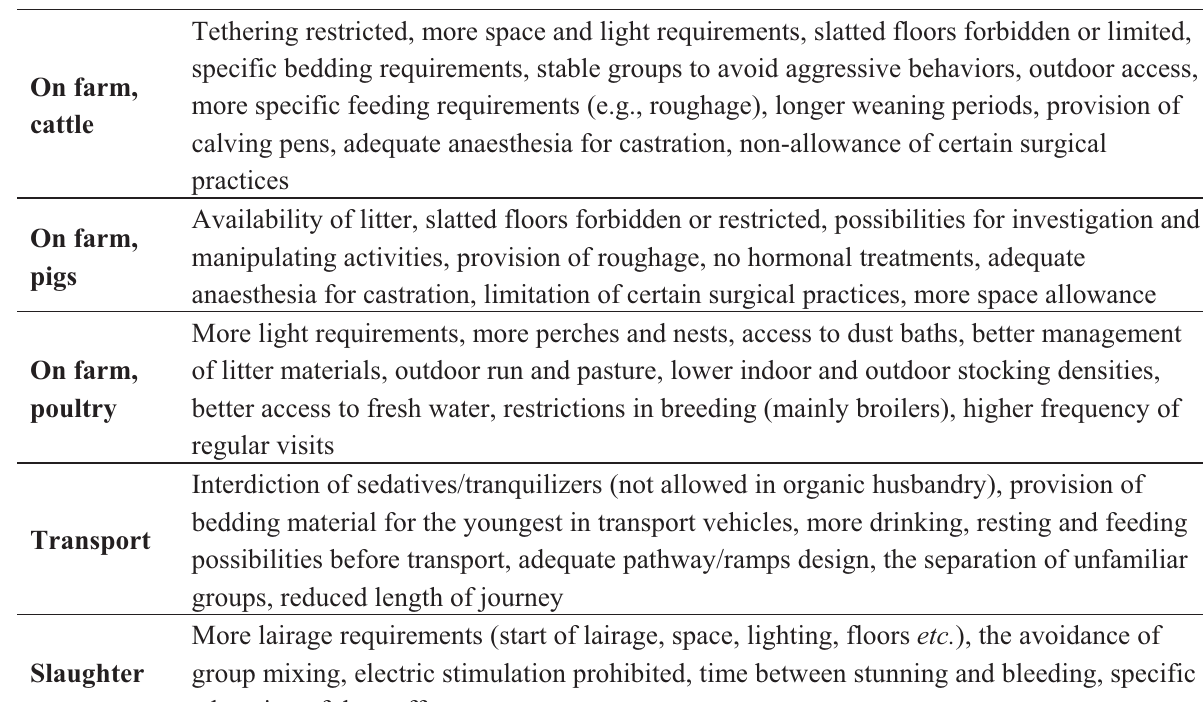
Table 1. Summary of the main aspects, found in at least five private standards and initiatives, with requirements beyond EU legislation, for each species on-farm, during transport, and at slaughter (source: